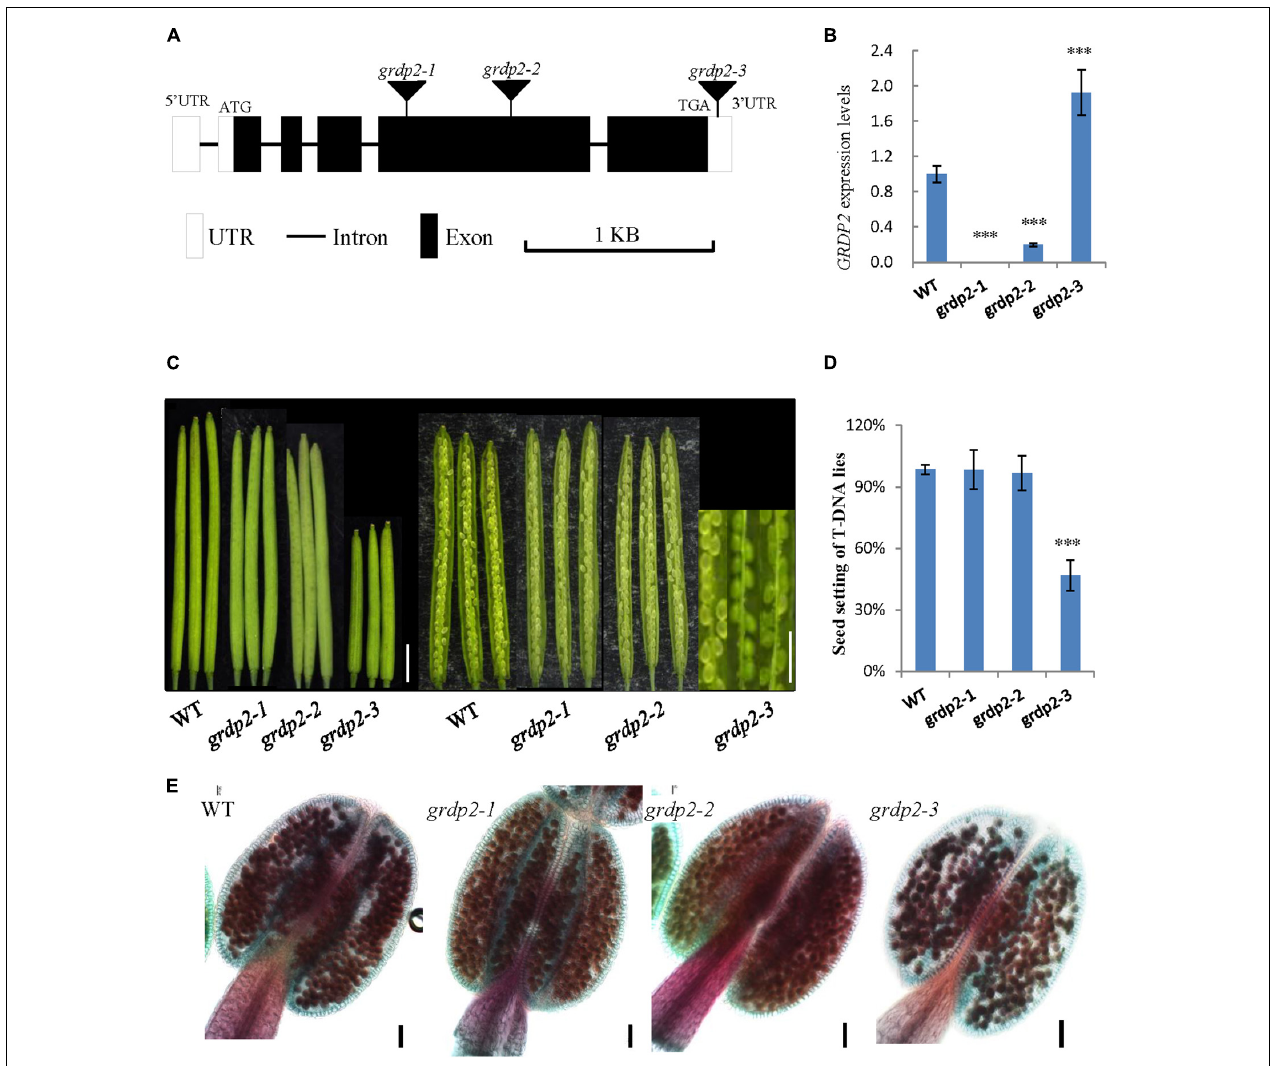
FIGURE 1 | Phenotype analysis of grdp2 T-DNA mutant. (A) Gene structure of GRDP2 and T-DNA insertion sites of the mutant alleles in grdp2 . White boxes show UTRs; gray lines show introns; black boxes show exons. (B) Expression level of the three T-DNA insertion lines as determined by real-time RT-PCR. (C) Seed development in wild-type (WT) plants and the grdp2 mutant alleles. Bar = 1 cm. (D) Seed setting statistics of three T-DNA insertion lines. (E) Alexander’s staining of pollen from WT and three grdp2 mutant alleles. The red color indicates viable pollen. Bar = 50 µ m. The asterisks show the significance level ( ∗∗∗ p < 0.01) as judged by the Student’s t